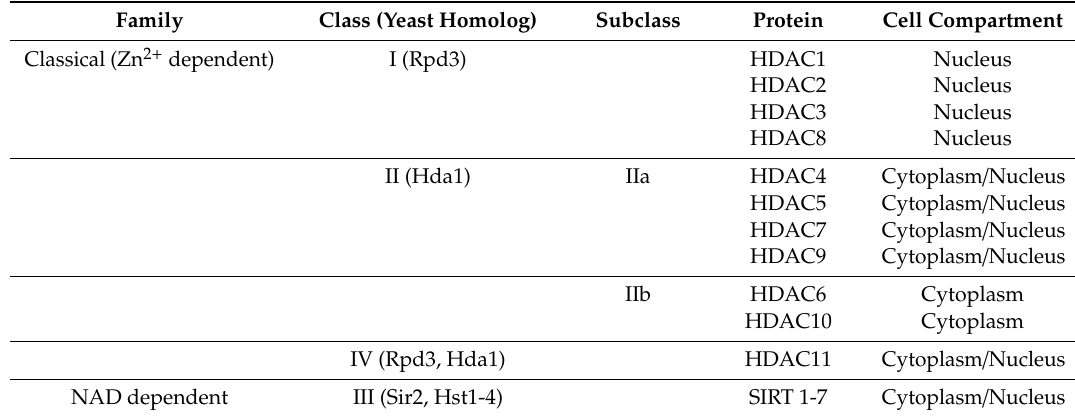
Table 1. Classification of histone deacetylases. The current manuscript will focus on ‘classical’, Zn 2 + -dependent